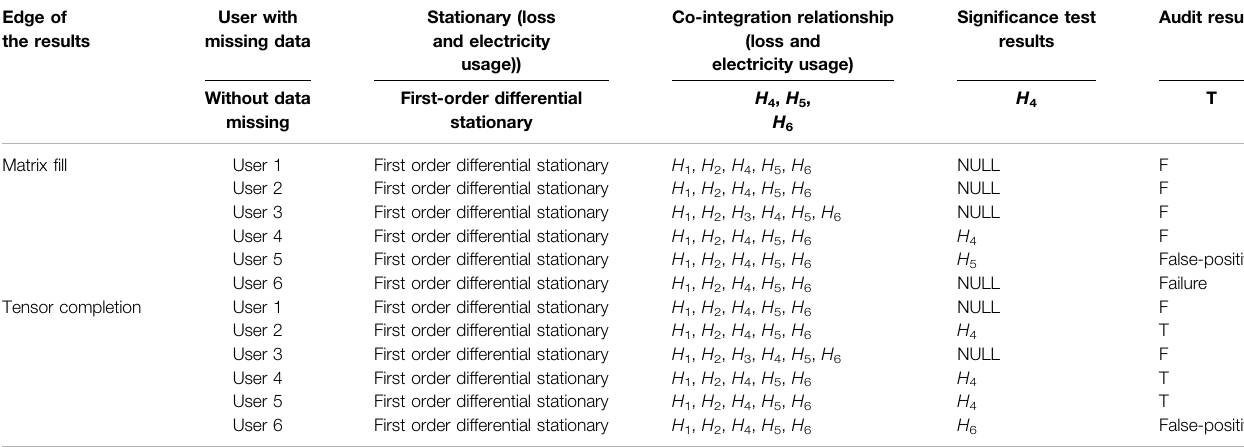
TABLE 8 | Results of Granger causality analysis of anomaly user with data